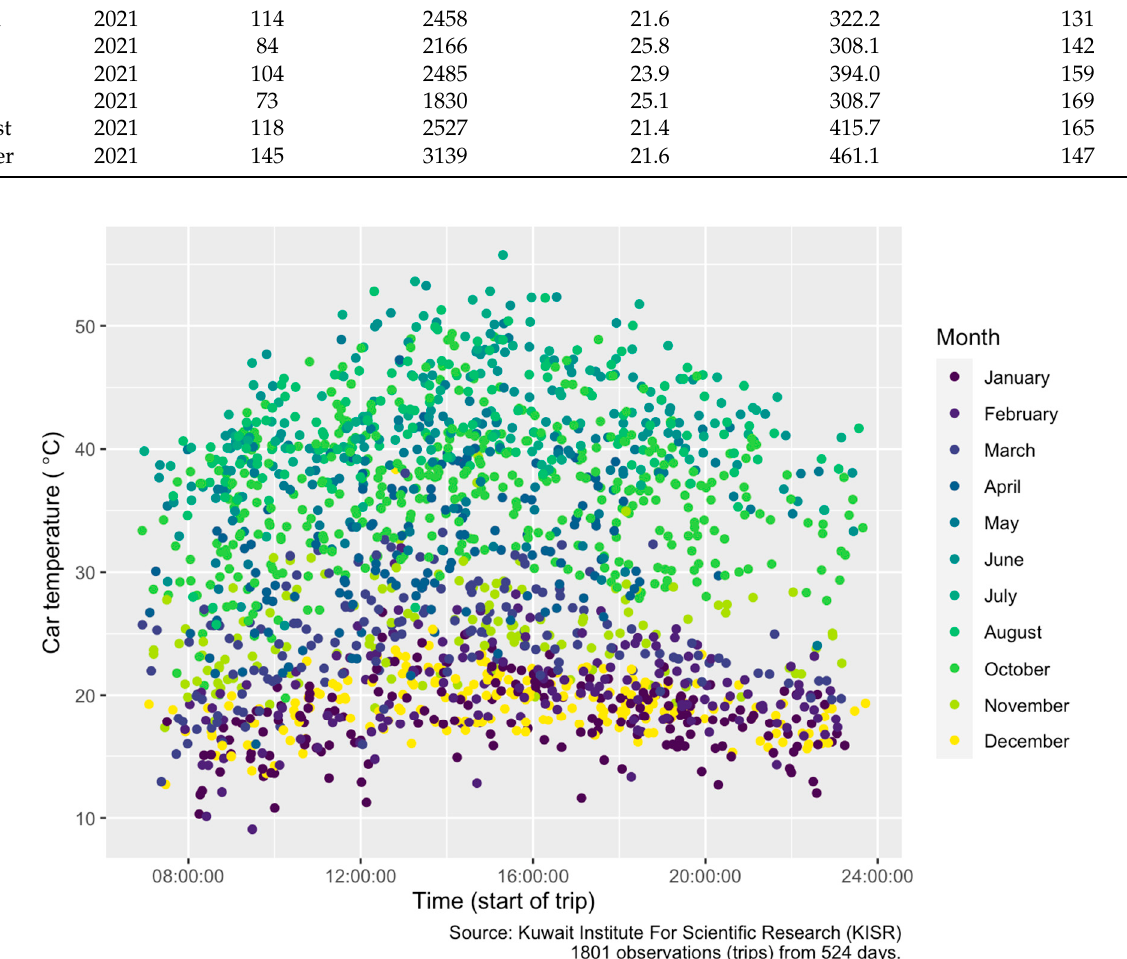
Figure 3. Scatter plot of recorded temperature measurements at the start of each journey against journey start time. Point colour indicates month of recorded journey.